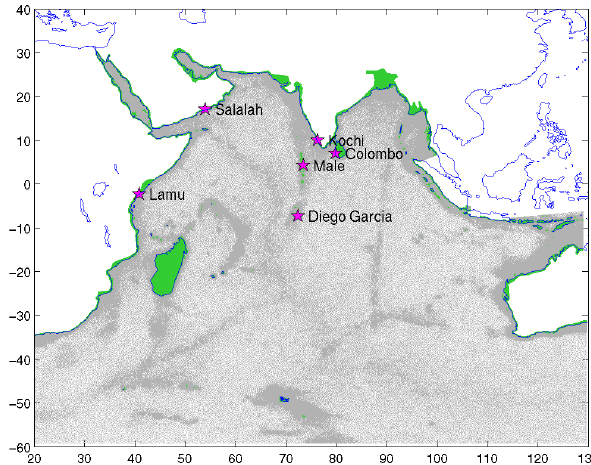
Fig. 5. Tide gauge locations and mesh density in the model domain. The green areas are land nodes which are initially dry. The resolu- tion ranges from 15km in the deep ocean to 40m in Aceh, Sumatra. Table 2. Satellite missions Jason 1 (J1) and Topex/Poseidon (T/P). The last columns quantify the RMS error obtained in the TsunAWI scenarios with different strike angles in subfaults A and C (Fig. 4) during the approx. 10min of the satellite